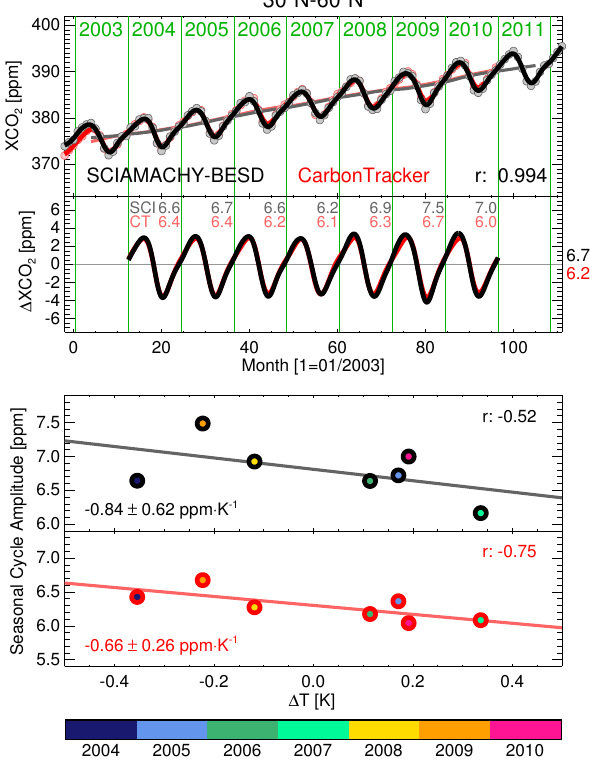
Fig. 5. Comparison of the SCIAMACHY (black) and Carbon- Tracker (red) XCO 2 for the north temperate zone (30–60 ◦ N) based on monthly means. Shown below are the detrended time series ob- tained by subtracting the deseasonalised trends (pale solid lines). Also noted are annual mean values of the seasonal cycle amplitudes (differences of maxima and minima of detrended seasonal cycle) as well as the mean value of the whole time period on the right-hand side. The bottom panel shows the covariation of annual seasonal cy- cle amplitudes and the Northern Hemisphere warm season (April– September) surface temperature anomaly.